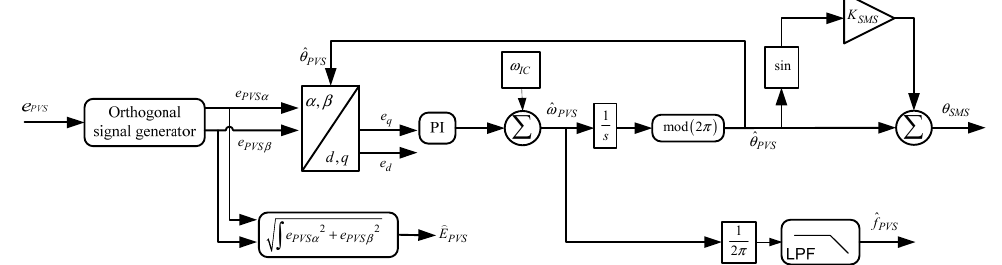
Figure 11. PVS PLL operation in case of SMS islanding-detection technique.